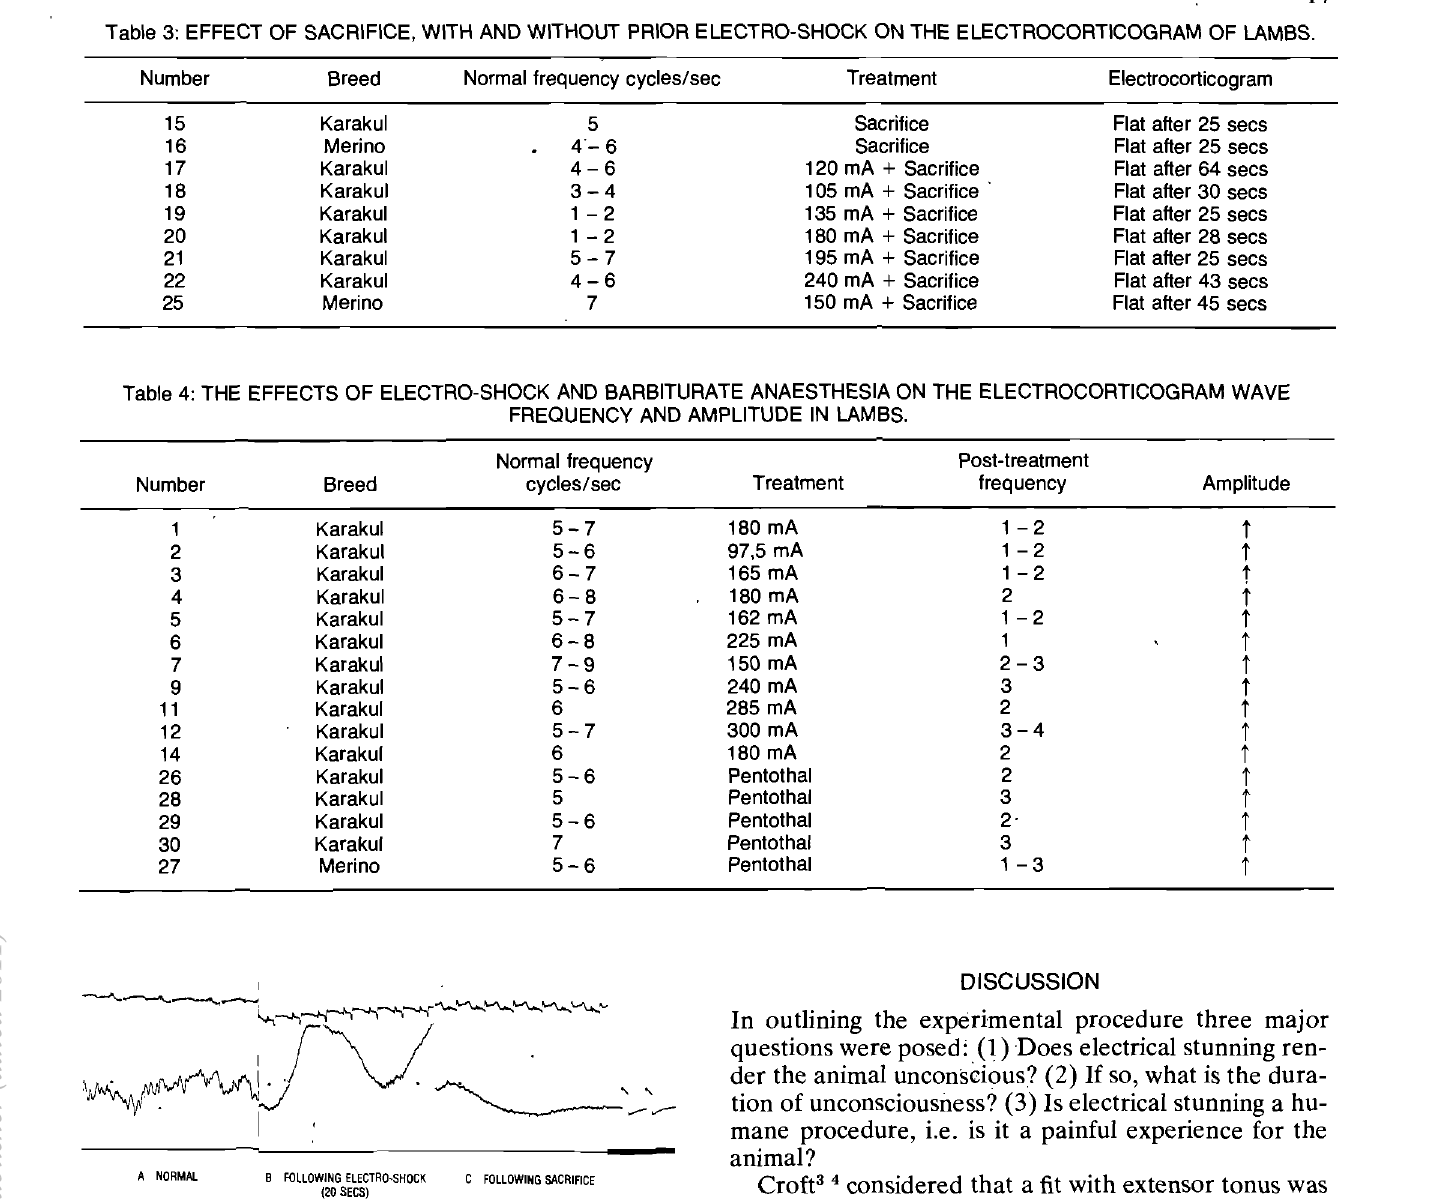
Fig. 5 Electrocortigrams from a lamb following electro shock and sacrifice. .